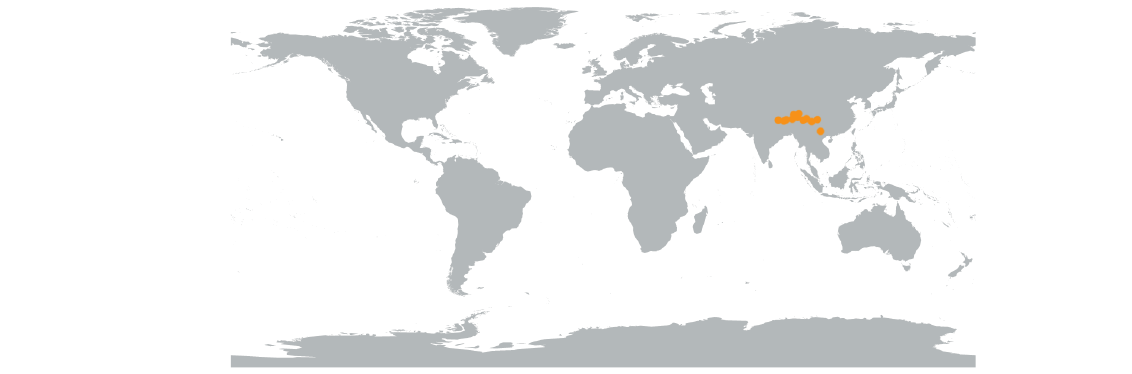
Fig. 33. Distribution of Malus sikkimensis (Wenz.) Koehne ex